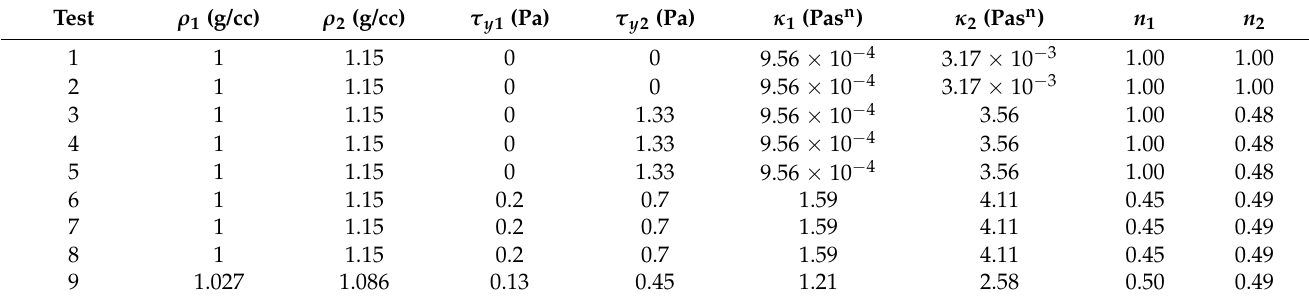
Table 3. Density and rheology of the displaced and displacing